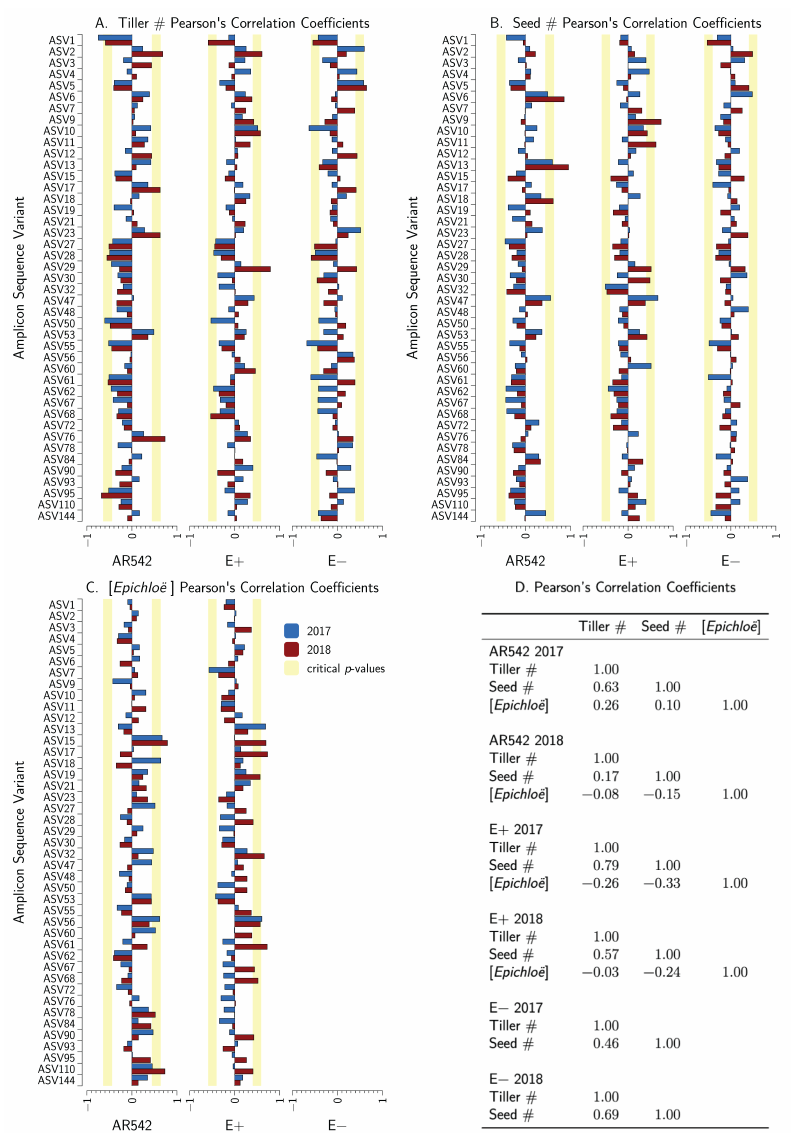
Figure 5. Relationship between core ASVs, plant fitness, and Epichloë concentrations. Blue bars denote 2017 results, red bars denote 2018 results. The vertical yellow bands denote the two-tailed critical values of r from p = 0.1 to p = 0.01. Negative values of r for seed and tiller number suggest the ASV is a plant antagonist and positive values of r suggest the ASV is beneficial to the plant. ( A ) displays the linear correlation coefficients for the draft core microbiome and tiller numbers per plant segmented by Epichloë treatment and year. ( B ) shows the same information but for seed numbers per plant. ( C ) displays the correlation coefficients for the draft core microbiome and Epichloë concentrations. ( D ) shows the correlations between tiller number, seed number, and Epichloë concentrations again segmented by Epichloë treatment and